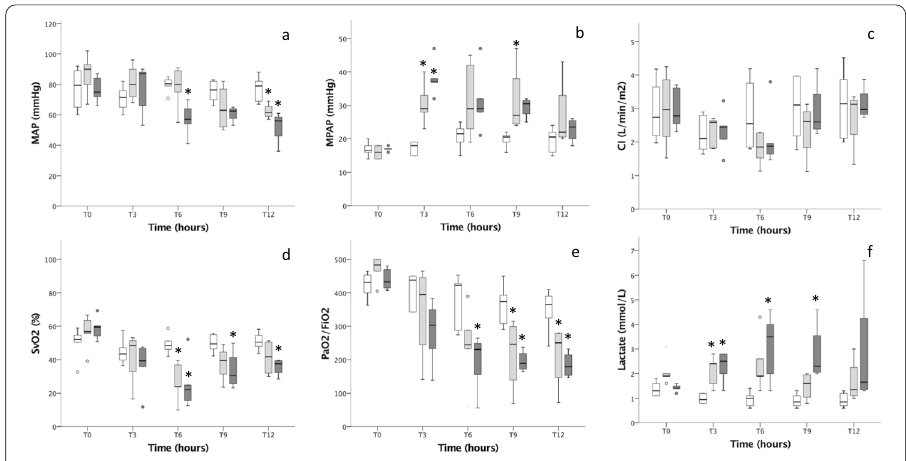
Fig. 1 a – f Preclinical experiments. Hemodynamic and respiratory changes during the preclinical experiments from start (T0) until the experimental endpoint (T12). Control (white), Sepsis-1 (light gray) and Sepsis-2 (dark gray). * p < 0.05 compared with control group, p -value from one-way ANOVA with Bonferroni correction. No difference found between Sepsis-1 and